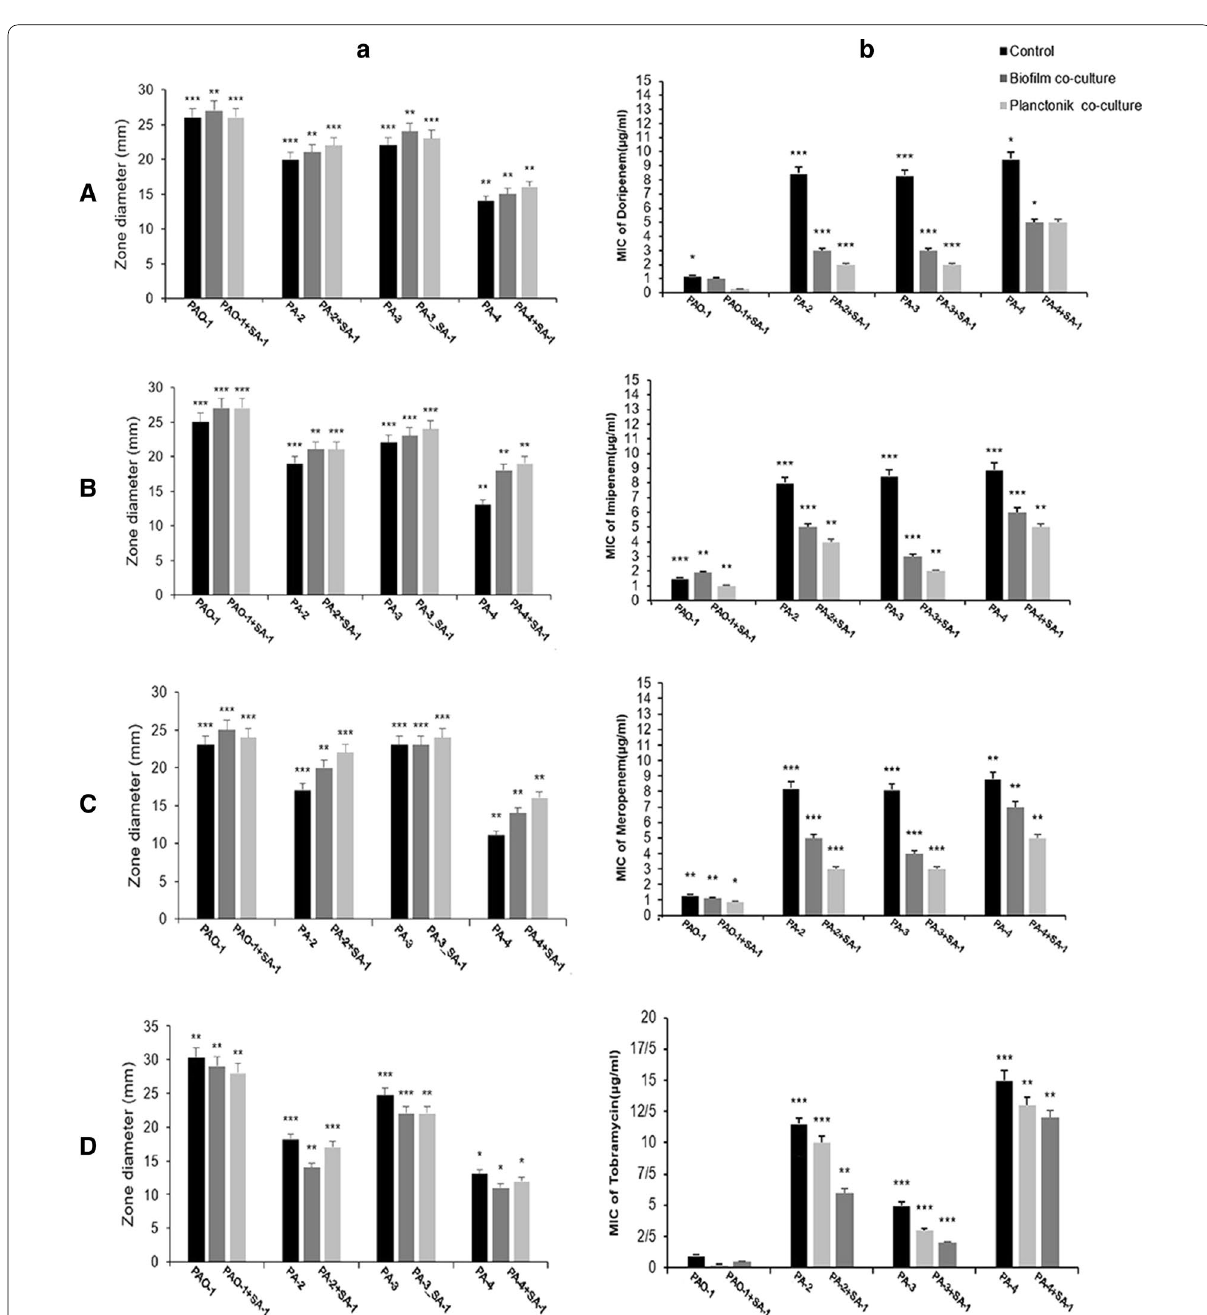
Fig. 2 The effect of S. aureus on the antibiotic resistance of P.aeruginosa strains. The inhibition zone ( a ) and the MIC ( b ) of antibiotics is demonstrated. The MICs of doripenem ( A ), imipenem ( B ), meropenem ( C ), and tobramycin ( D ) on the P. aeruginosa strains. ’*: p < 0.05, **: p < 0.001, ***: p < 0.0001. No stars: the non-statistical